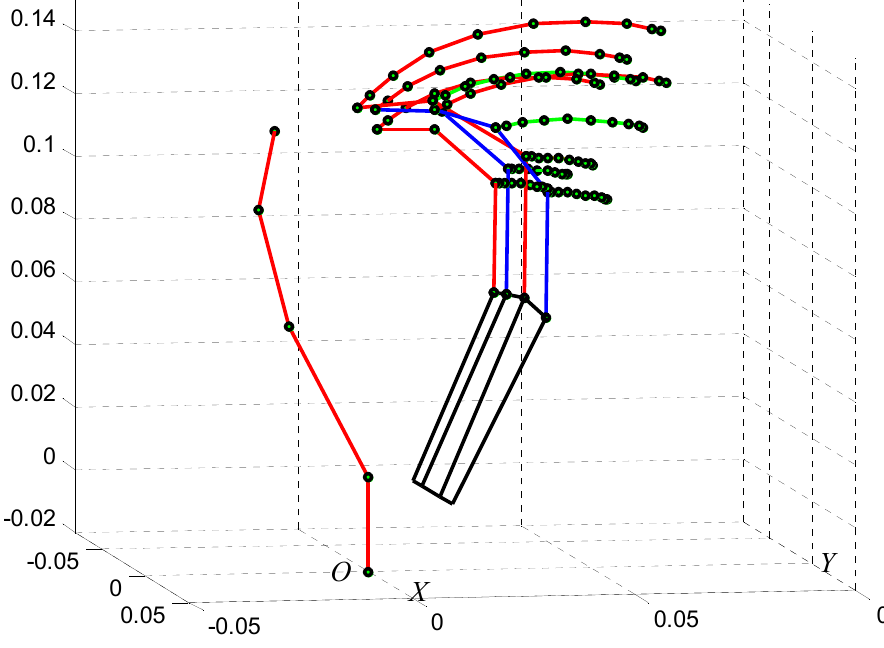
Figure 9. Simulation of fingertip trajectories.